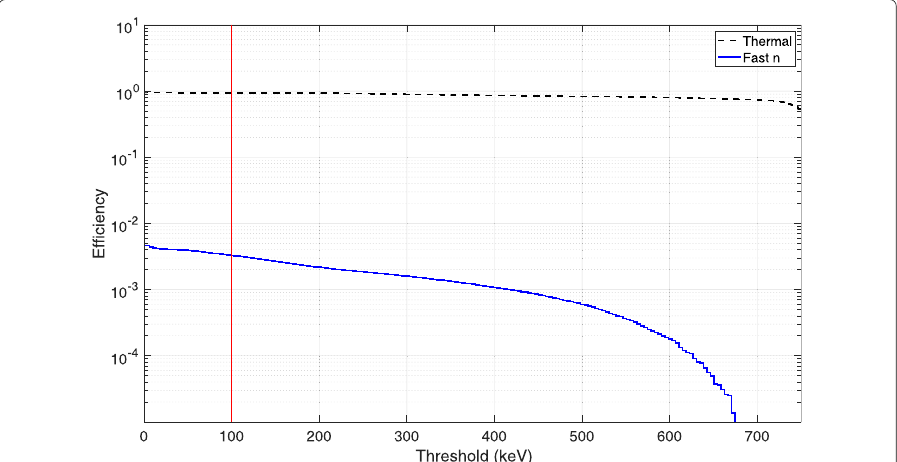
Fig. 9 Fast neutron sensitivity of the 3 He-detector as a function of an energy threshold E th = 100 keV. The threshold value has been taken in agreement to the threshold used for background discrimination based on previous works [31,